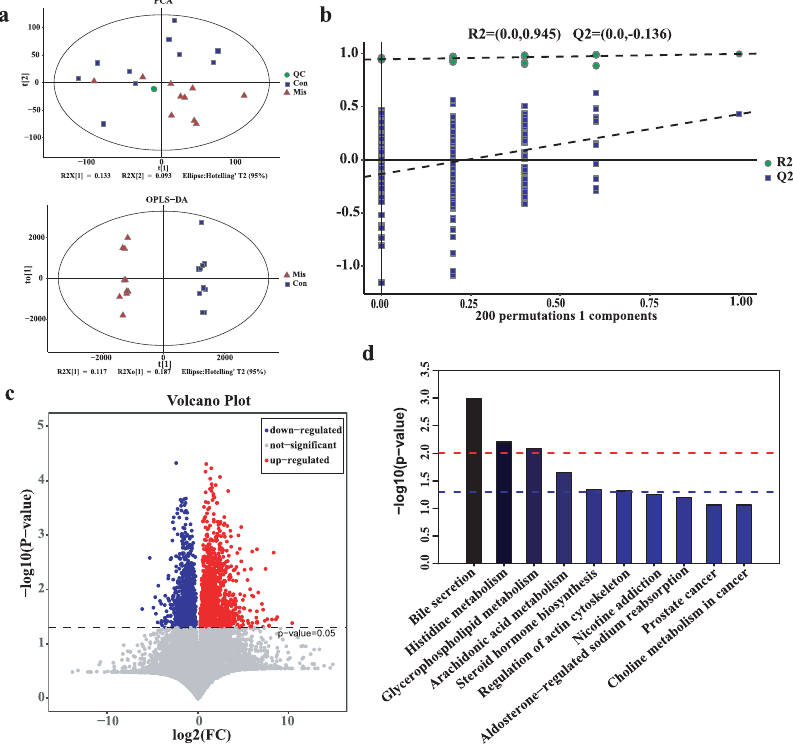
Fig. 4 Fecal metabolomics for quanti fi cation of metabolites in the miscarriage and control groups. a PCA and OPLS-DA score plots for differentiating the metabolites in each group. b The corresponding permutation test (200 times) for the OPLS-DA model. c Volcano plot showing the differentially accumulated metabolites in the miscarriage (Mis) and control (Con) groups. Red dots indicate the metabolites upregulated in the miscarriage group, and blue dots indicate the metabolites down-regulated in the miscarriage group. d Enriched KEGG pathways in the miscarriage group compared with the control